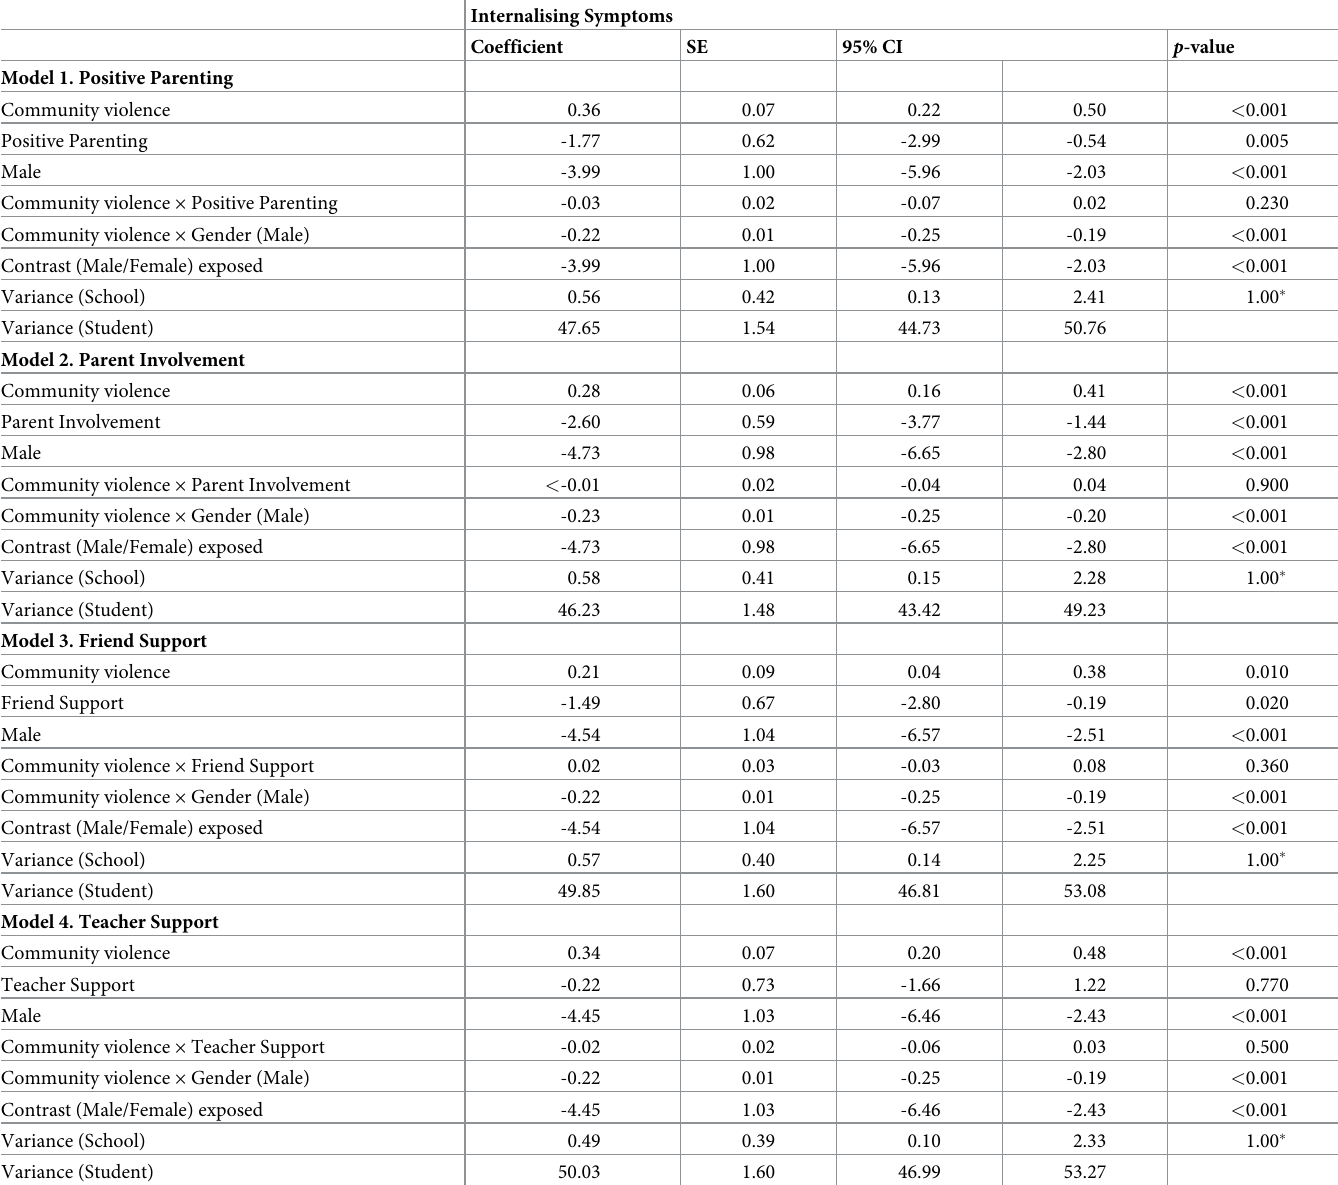
Table 6. Linear mixed-effects models of exposure to community violence, type of social support & interactions